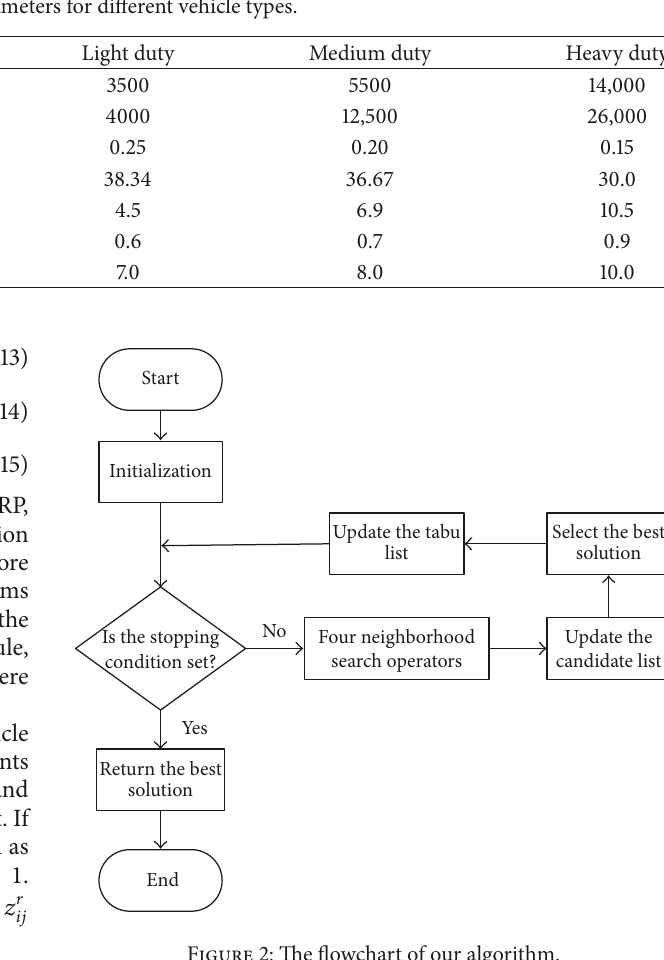
GOVRP. The flowchart of this algorithm is shown in Figure